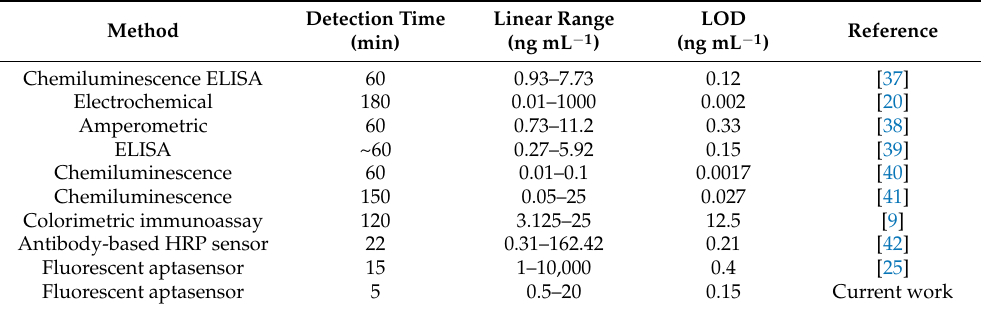
Figure 3. ( a ) Fluorescence emission spectra of the aptasensor in the addition of FB 1 at various concentrations. ( b ) Linear relationship between the fluorescence intensity and FB 1 concentrations in the range of 0.5 to 20 ng mL −1 . Table 1. Comparison of the analytical performance of currently available methods for the detection of FB 1 .